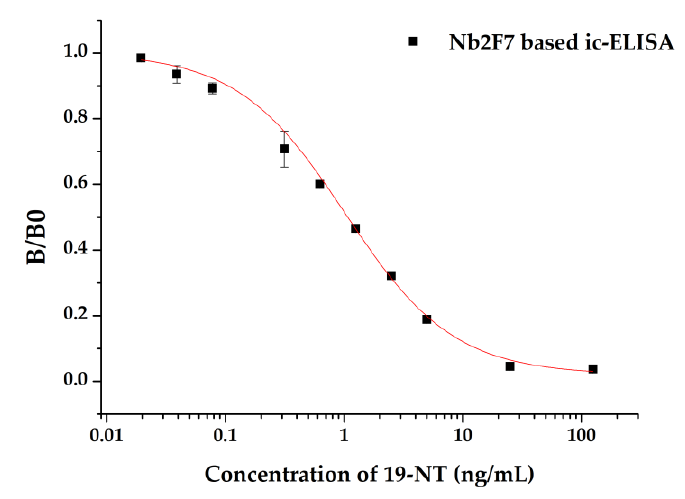
Figure 9. Standard competitive inhibition curve for 19-NT analysis. Table 2. Sensitivity of Reported Anti-19-NT Reagents.